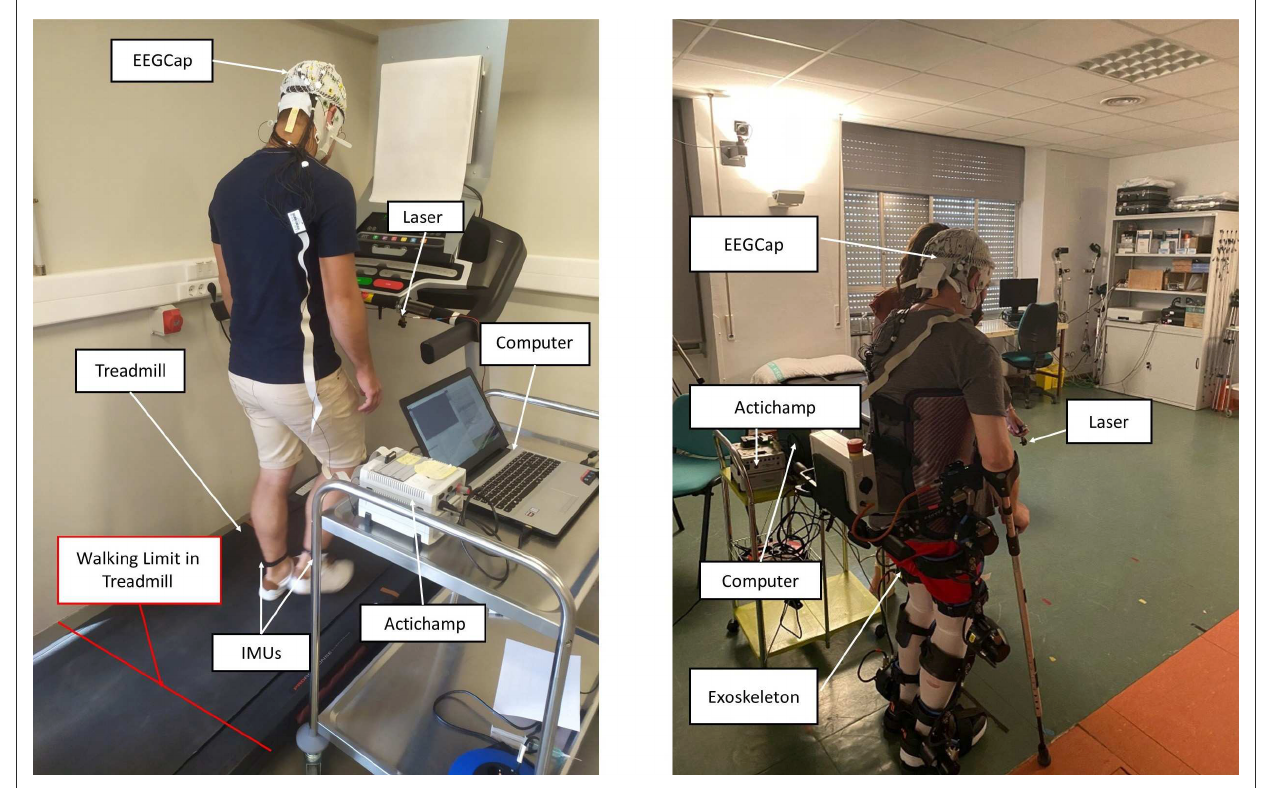
FIGURE1 Treadmill setup for healthy subject (Left) ; and setup with exoskeleton for healthy subject and non-able bodied patients (Right) .